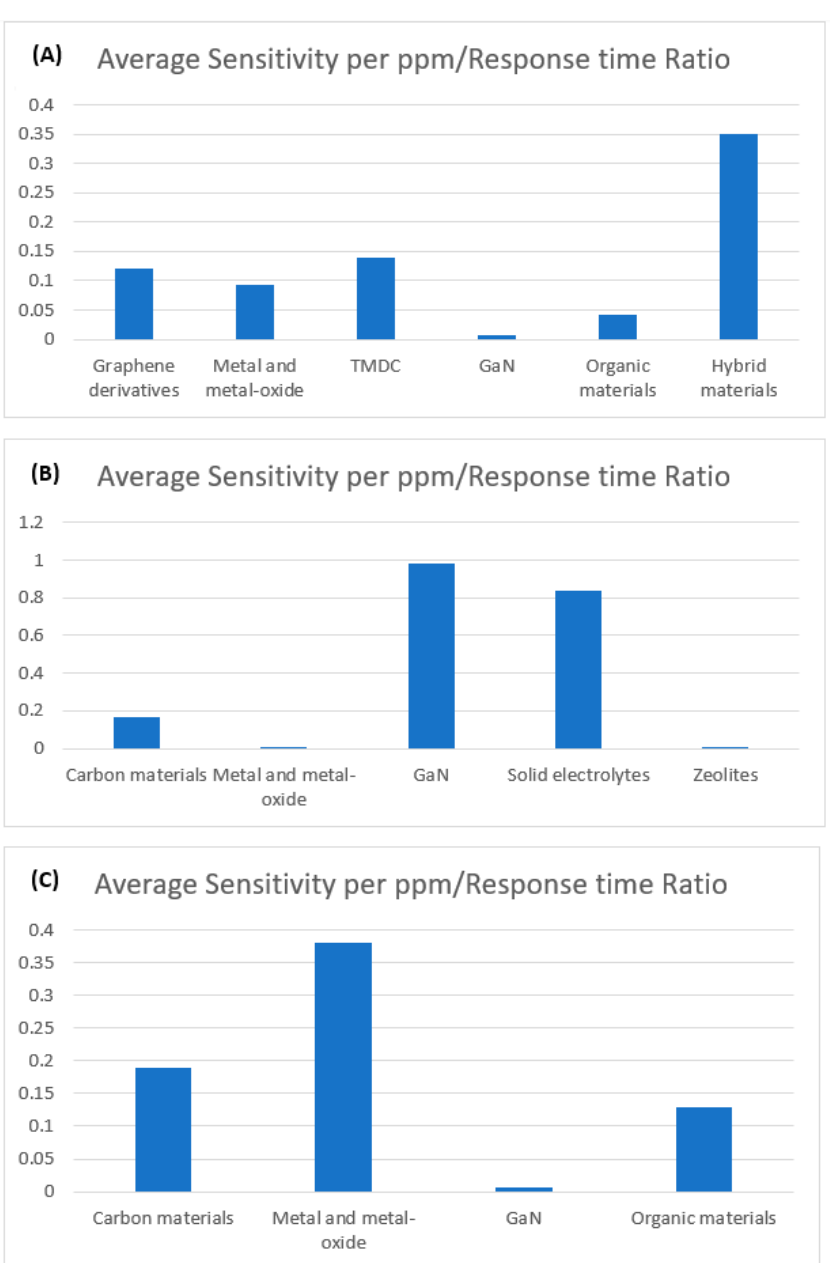
Figure 16. Average sensitivity per ppm/response time ratio comparison among various sensing materials reported in recent years for ( A ) NO 2 ( B ) SO 2 and ( C ) H 2 S gas sensors.